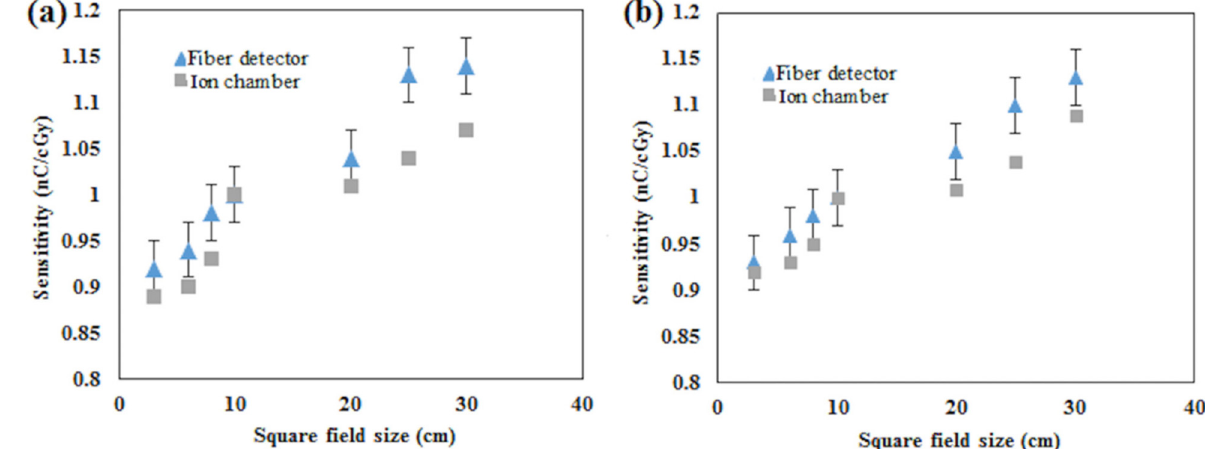
Fig 3. Sensitivity dependency of the 42 μ m core-size fibre on field size. Sensitivity dependency on field size measured for (a) 6MV and (b) for 10MV X-rays of the 42 μ m core-size fibre.